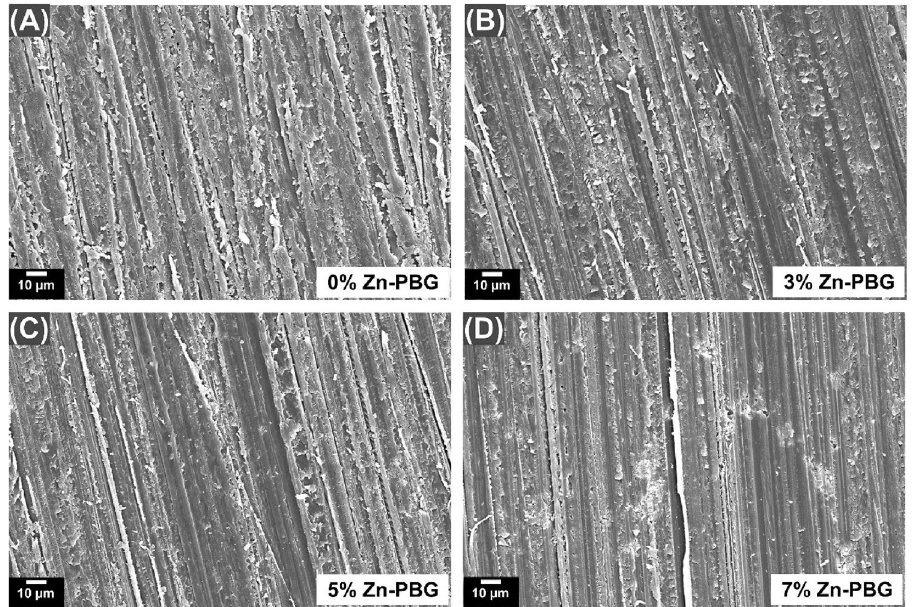
Figure 3. Scanning electron micrographs of the surfaces of various auto-polymerized acrylic resin samples used in this study at 500 × magnification: ( A ) control; ( B ) 3% Zn-PBG; ( C ) 5% Zn-PBG; ( D ) 7% Zn-PBG.